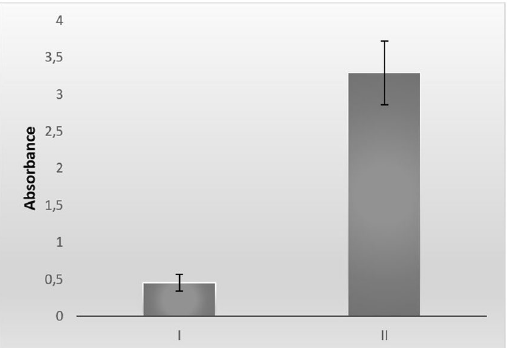
Figure 1. Absorbance values of ELISA. I: The anti-SAG1 IgY antibody amount of eggs in the control group. II: The anti-SAG1 IgY antibody amount of immunized chicken eggs with SAG1.